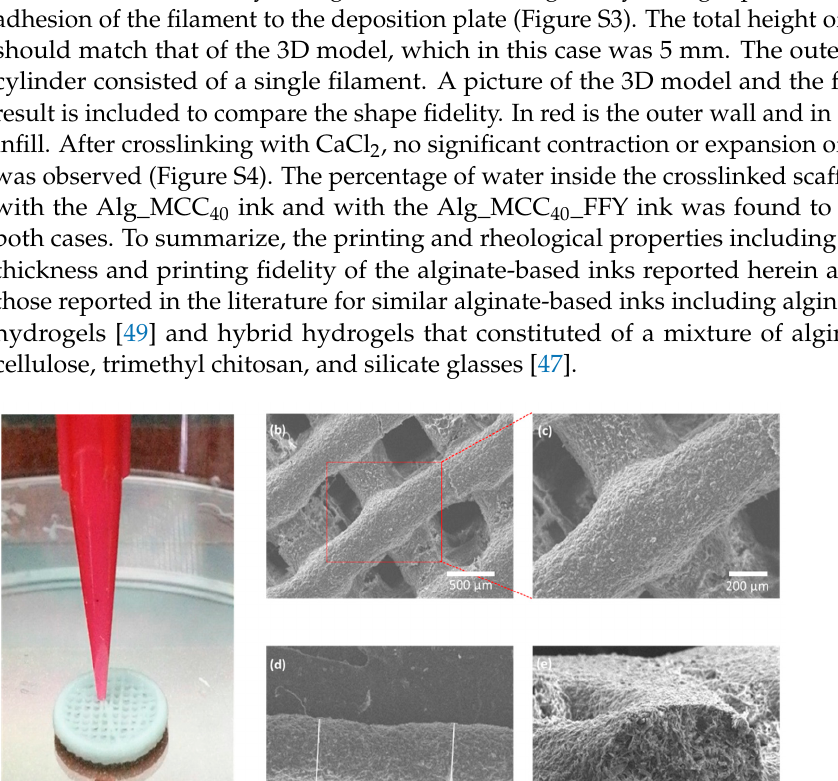
Figure 7. ( a ) The ATR ‐ FTIR spectra of the inks: Alg (red curve), Alg_MCC 40 (green curve), and Alg_MCC 40 _FFY (purple curve), Fmoc ‐ FFY (black curve) and ( b ) zoom ‐ in of the area of interest. Note that the numbers indicate the relevant peaks.